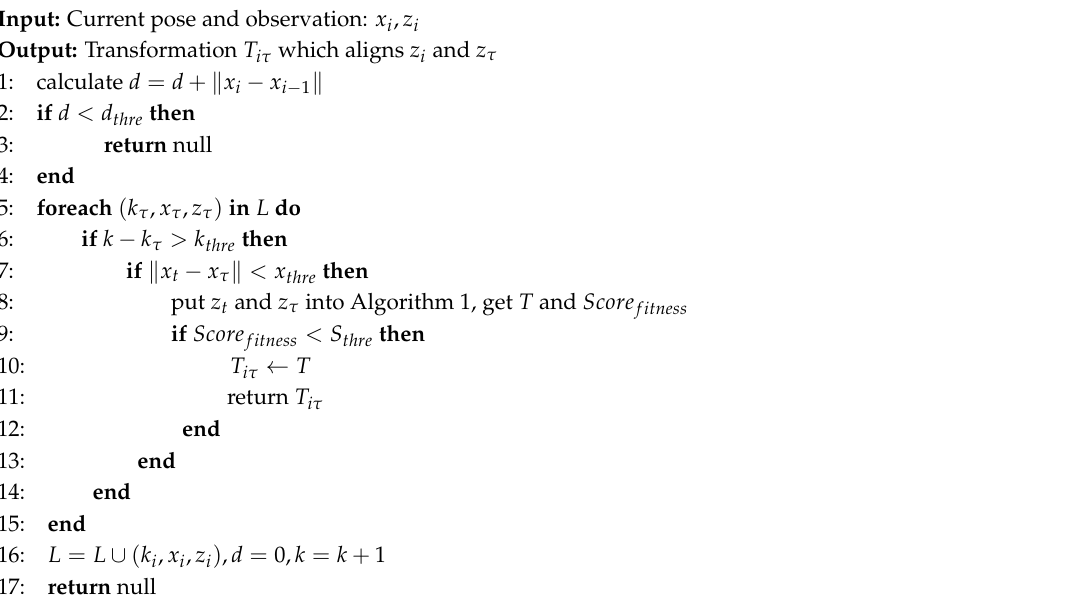
Algorithm 2: Matching the current frame with an area-neighbor